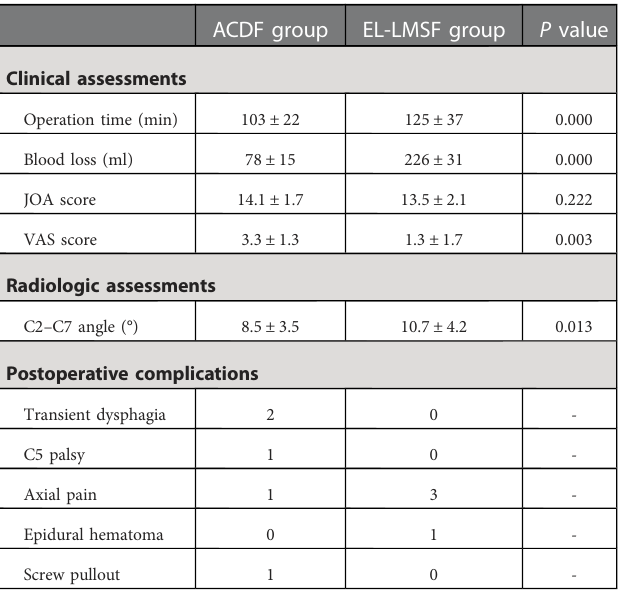
TABLE 2 Surgical results, radiology assessment and